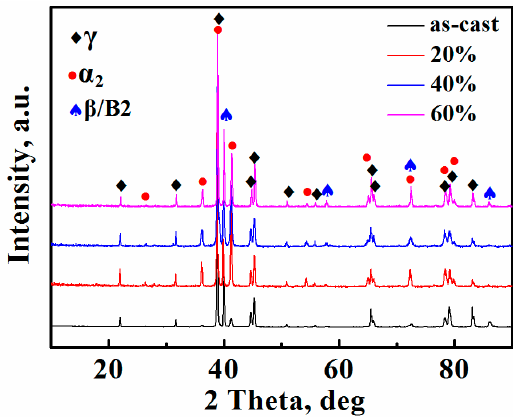
Figure 6. XRD patterns obtained from as-cast Ti-44Al-4Nb-1.5Cr-0.5Mo-0.2B alloy, 20% reduction sample, 40% reduction sample and 60% reduction sample.